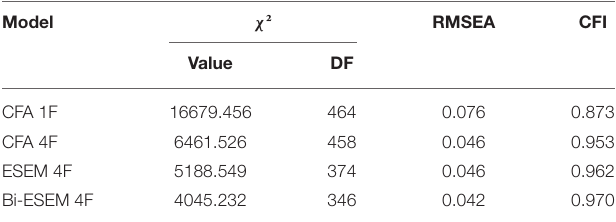
TABLE 1 | χ ² -test and fit indices for different structures.